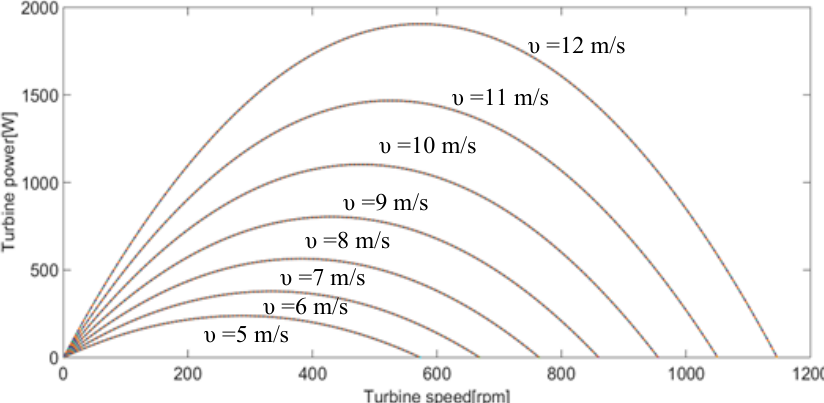
Figure 2. Wind turbine characteristic curves: Wind turbine power (Watt) vs. rotational speed (rpm).